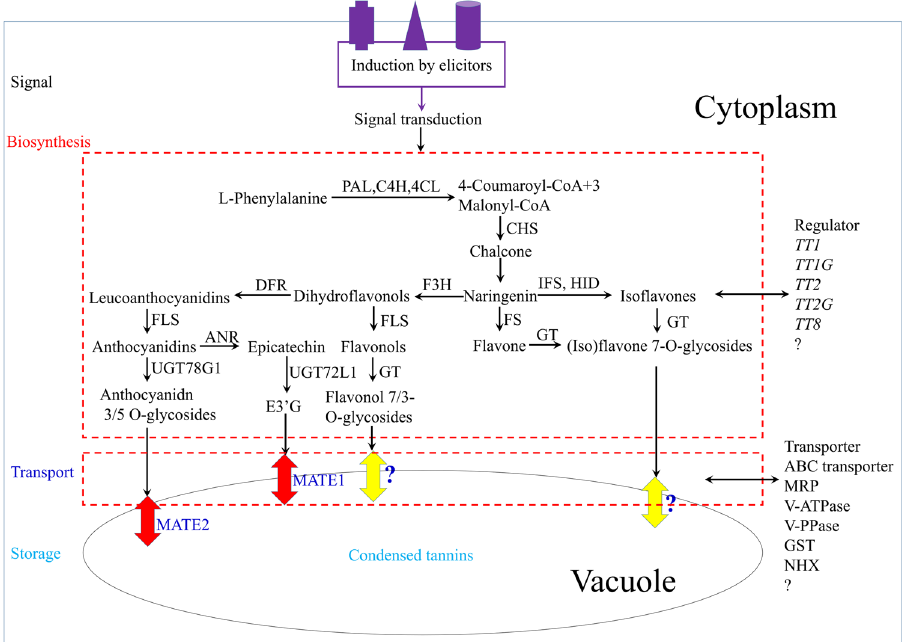
Figure 11. A model of potential flavonoid and isoflavonoid metabolic processes in M . truncatula . PAL, L-Phe ammonia-lyase; C4H, cinnamate 4-hydroxylase; 4CL, 4-coumarate:CoA ligase; CHS, chalcone synthase; CHI, chalcone isomerase; F3H, flavanone 3-hydroxylase; DFR, dihydroflavonol reductase; FS, flavone synthase; IFS, isoflavone synthase; HID, 2-hydroxyisoflavanone dehydratase; FLS, flavonol synthase; ANS, anthocyanidin synthase; ANR, anthocyanidin reductase; GT, glycosyltransferase; MaT, malonyl CoA:flavonoid acyltransferase; MATE, multidrug and toxin extrusion transporter; V-ATPase, vacuolar ATPase; GST, glutathione S-transferases; NHX, H/Na